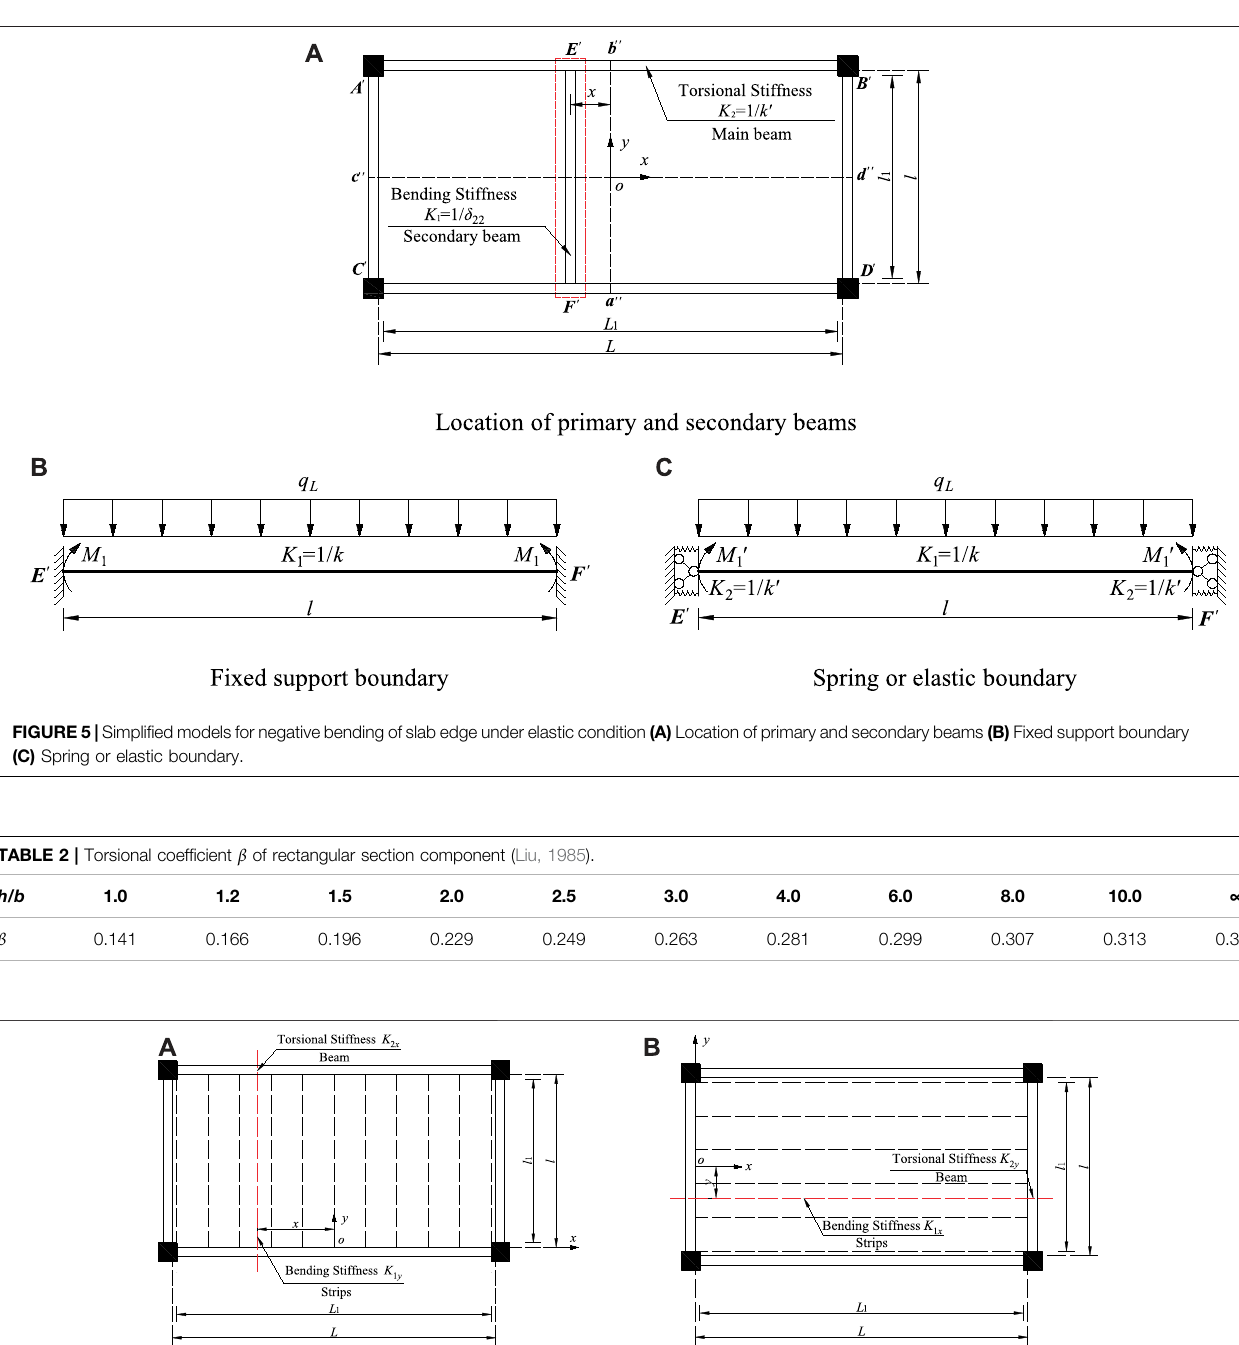
FIGURE 6 | Strap division of the panel (A) y direction strip (B) x direction strip.